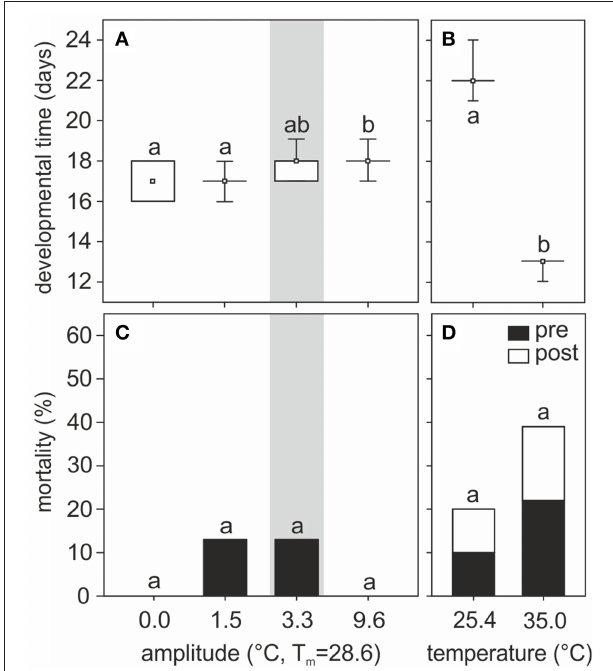
FIGURE 2 | (A,B) Pupal developmental time and (C,D) mortality rates of individuals reared at (A,C) different amplitudes of fluctuating temperature or (B,D) constant temperature regimes. Developmental time is shown as boxplots: boxes show quartiles, whiskers provide the minimum and maximum values, and small squares represent medians. Percentage of pre- and post- eclosion mortality for each group is indicated by black and white bars, respectively. Gray area indicates the temperature regime selected by nurses for brood translocation. Different letters show significant differences among different amplitudes of fluctuating temperature or between constant temperatures regimes. Developmental time: N 0 = 15 , N 1.5 = 14 , N 3.3 = 13 , N 9.6 = 16 , N 25.4 = 18 , N 35 = 18 . Mortality: N 0 = 15 , N 1.5 = 16 , N 3.3 = 15 , N 9.6 = 16 , N 25.4 = 20 , N 35 = 23 .